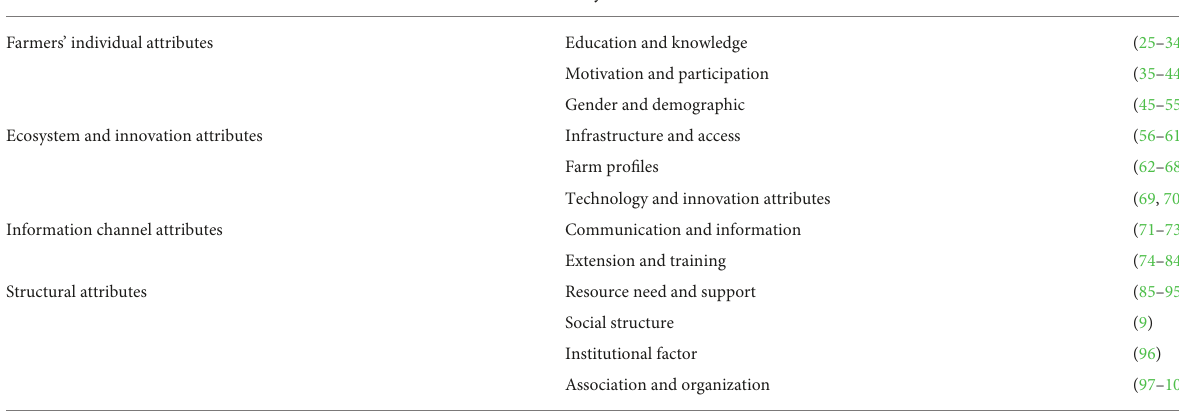
TABLE 4 Attributes, main determinants and list of reported studies –